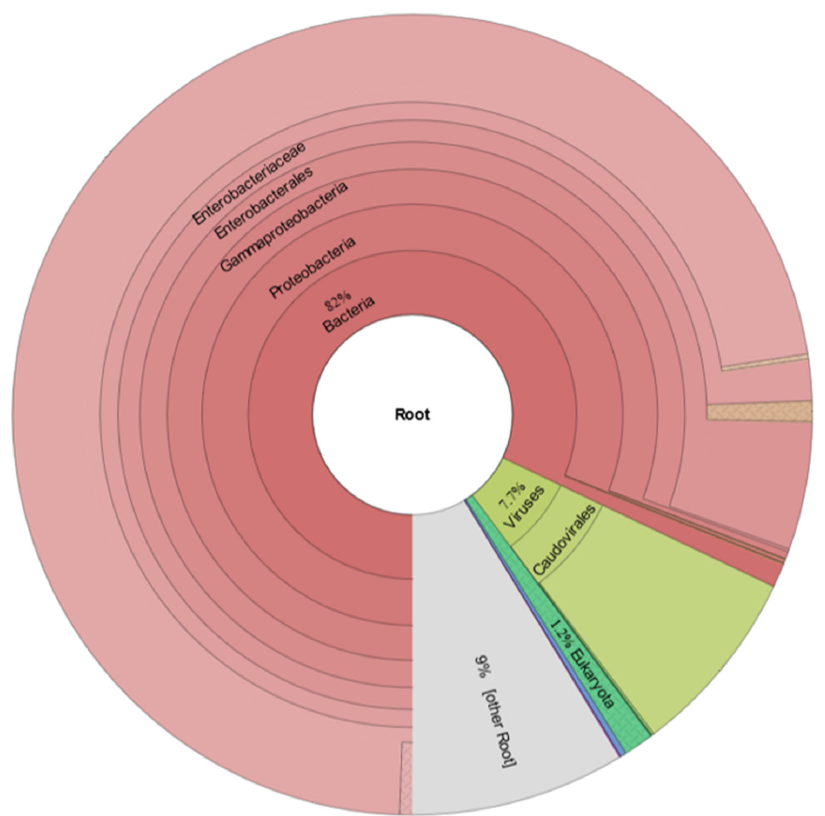
Figure 3. Summary of metagenomics of esophageal papillary proliferation sample used in the study. To identify the bacteria, the bacterial 16S ‐ 23S rRNA gene region was amplified and sequenced. A total of 56,412 bacterial reads were obtained from the esophageal papillary proliferation sample, with a dominance of Bradyrhizobium sp. (85.1%), Sphingomonas sp. (8.1%), and Gordonia sp. (6%) (Table 1). A total of 80,013 bacterial reads were obtained in the control sample, with a dominance of Lactobacillaceae (49.2%), Staphylococcus sp. (11.6%), Veillonella sp. (8%), and Bifidobacterium sp. (7.4%). Most of the reads in the esoph ‐ ageal papillary proliferation sample were Bradyrhizobium sp., which was not found in the control (Table 1). Table 1. Bacteria identified using the 16S ‐ 23S rRNA gene region with esophageal papillary prolif ‐ eration sample and control. Bacteria